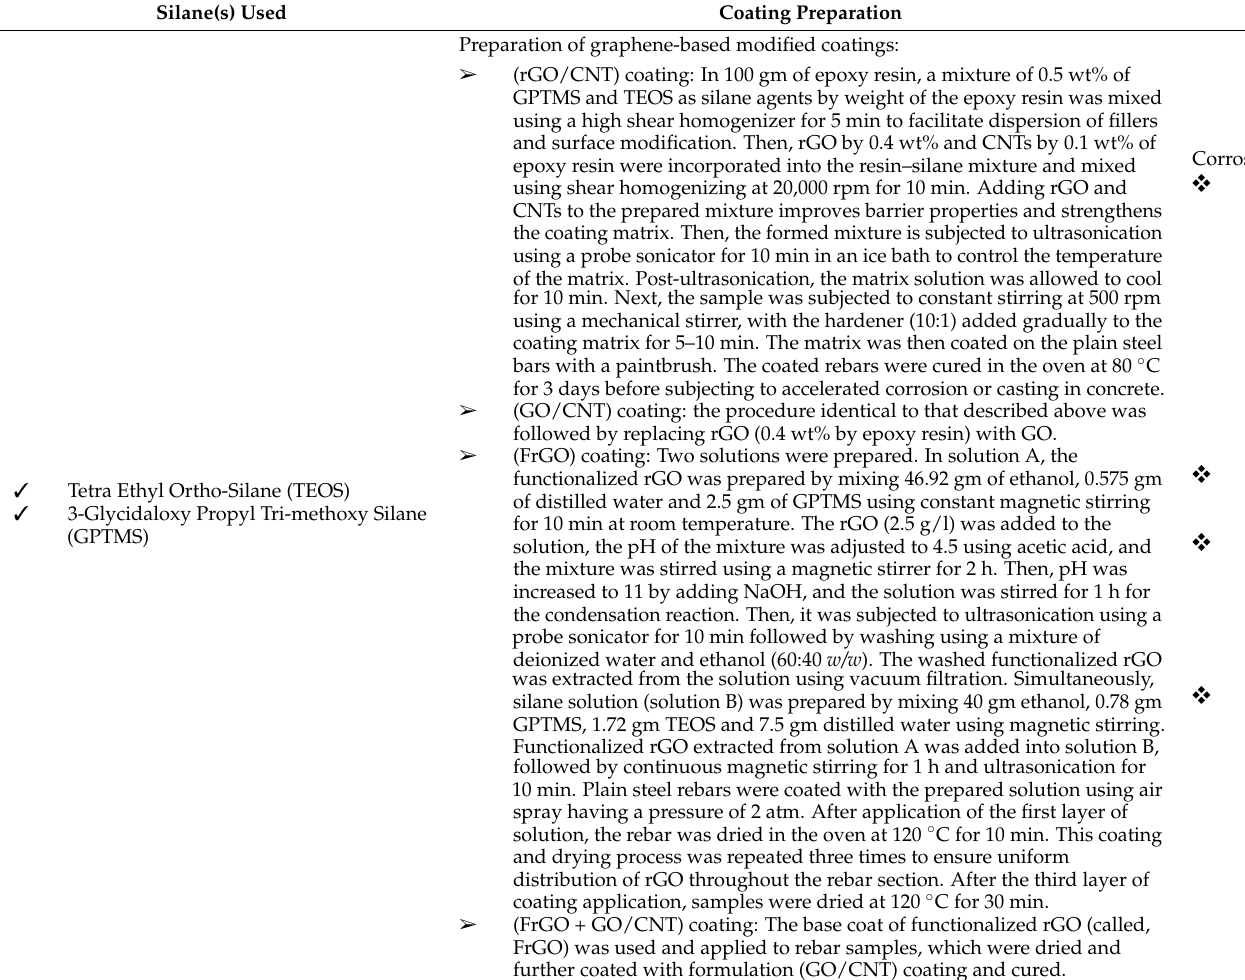
Table 1. Different approaches for improving silane coatings and the main findings, as reported in the